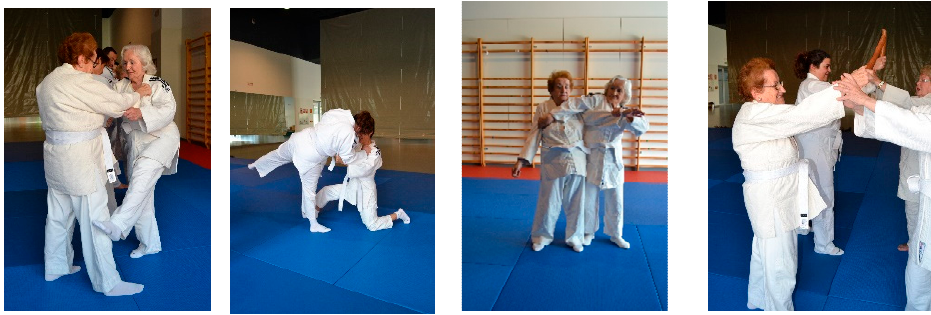
Figure 11. Movements adapted from Nage Waza and Katame Waza.